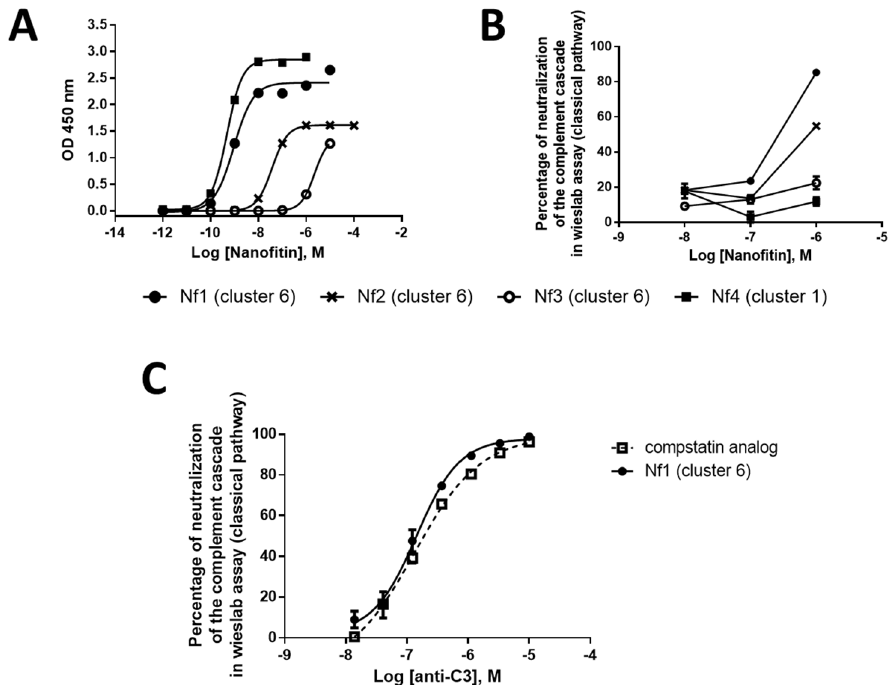
Figure 2. Nanofitin (in pAFG48) ( A ) binding dose–response relationship by ELISA (n = 1), ( B ) com- plement cascade inhibition by the Wieslab assay of classical pathway functional activity (n = 1), and ( C ) Nf1 complement cascade inhibition compared with a compstatin analog by the Wieslab assay (n = 1). ELISA, enzyme-linked immunosorbent assay; Nf, Nanofitin.